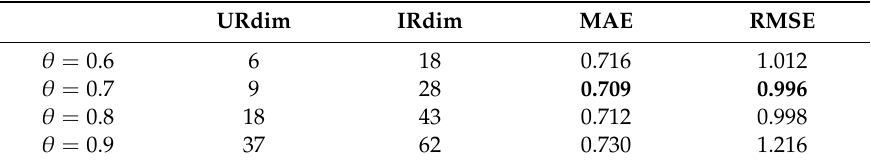
Table 10. Performance comparisons among di ff erent values of θ